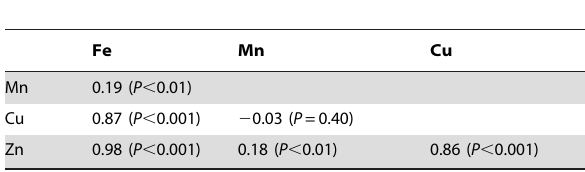
Table 2. Pearson correlation coefficients ( r ) between singularity indices of joint multifractal spectra for selected soil trace